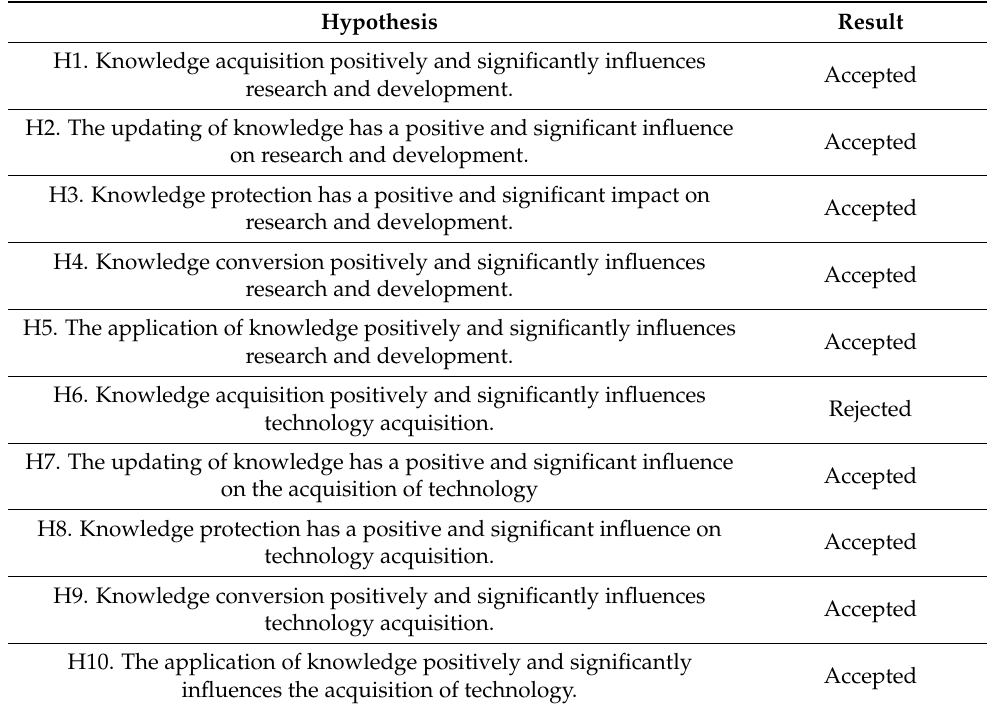
Table 5. Hypothesis